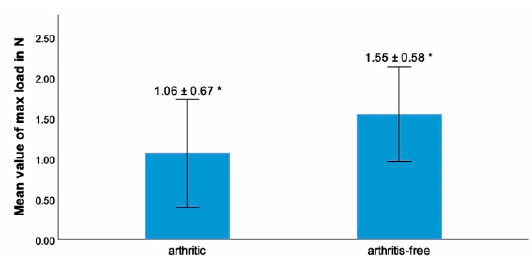
Figure 4. Differences in maximum applied load in N over the entire meniscus-covered cartilage tissue ( p = 0.04): arthritic: 1.06 ± 0.67 N (error bar: 1 SD); arthritis-free: 1.55 ± 0.58 N (error bar: 1 SD); * = statistically significant with p < 0.05.